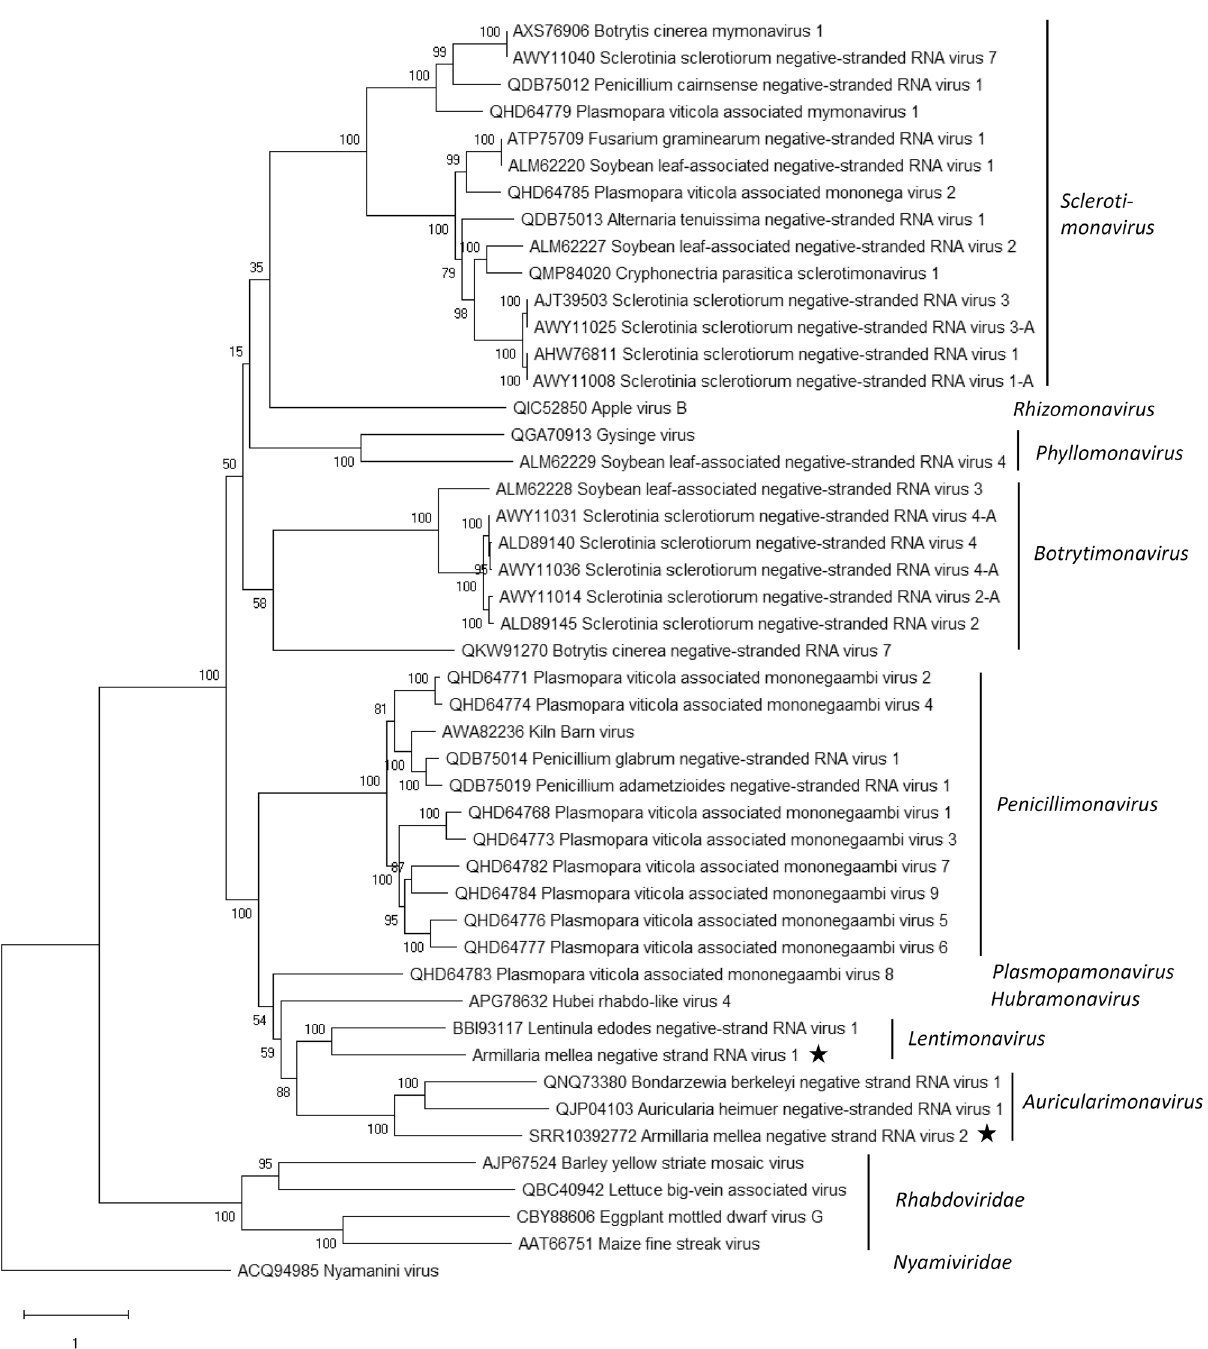
species (although no species delimitation criteria are available for this novel group of viruses 28,29 ), and were des-